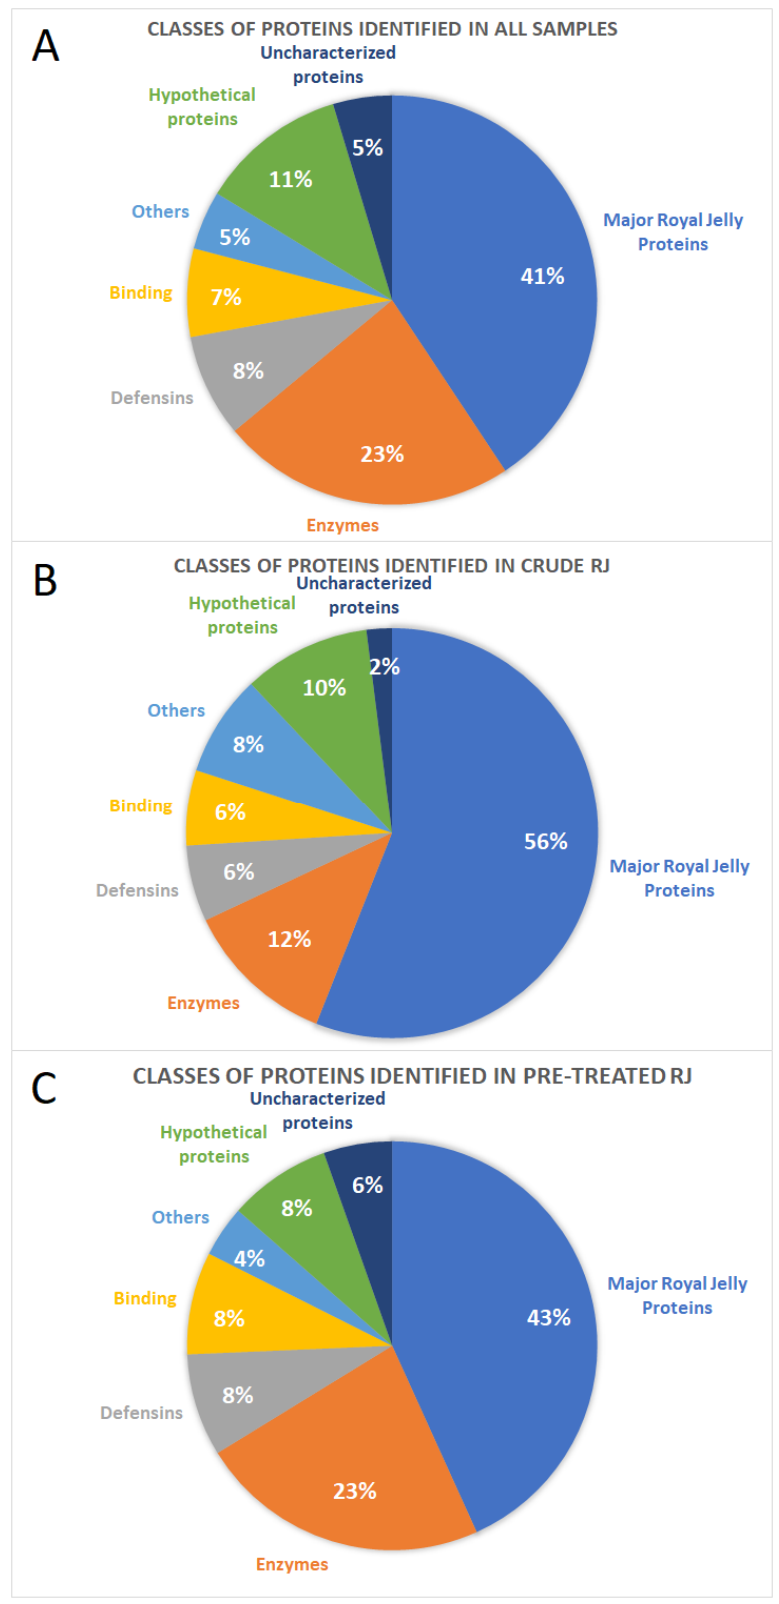
Figure 2. Classes of proteins identified ( A ) in total in all RJ “crude” and pre-treated; ( B ) only in crude (non-ProteoMiner TM pre-treated) RJ samples; ( C ) only in ProteoMiner TM pre-treated RJ samples.